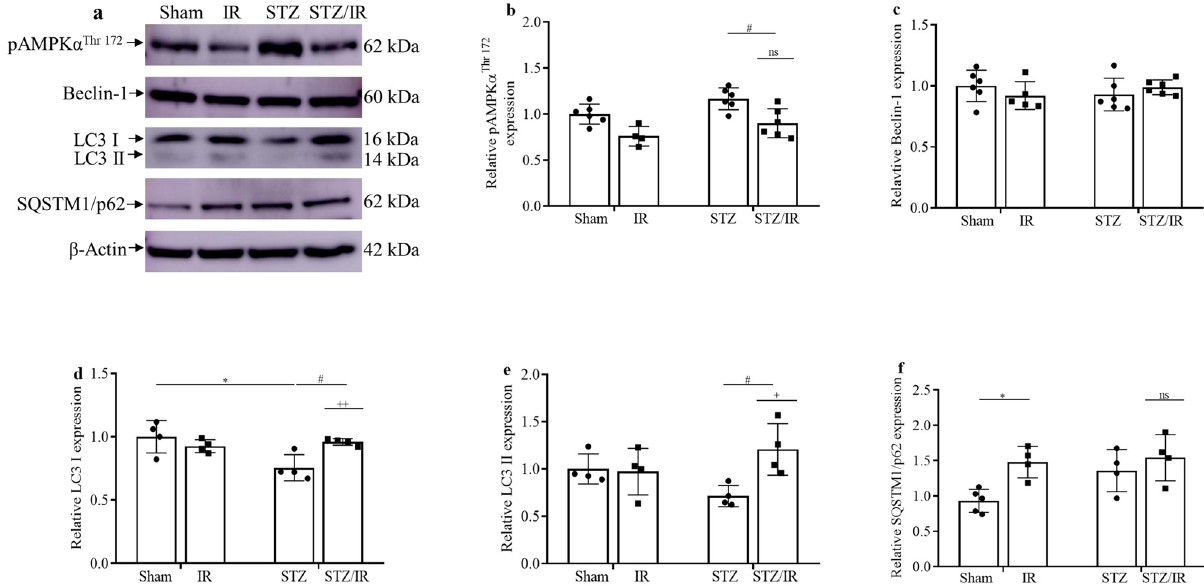
Figure 4. Effect of renal ischemia/reperfusion in vehicle- and STZ-treated mice on the protein expression ( a ) of phosphorylated AMPKα Thr 172 ( b ), beclin-1 ( c ), LC3 I ( d ), LC3 II ( e ), and SQSTM1/p62 ( f ). + p < 0.05, ++ p < 0.01 for the interaction between diabetes and renal IR (STZ/IR), as indicated by two-way ANOVA (Supplementary Table S2). The Bonferroni post hoc test was also performed: *p < 0.05 vs sham group; # p < 0.05 vs STZ group. The values are the mean ± SD (n = 4–6). The samples were obtained from the same experiment, and the blots were processed in parallel. Sham sham-operated, IR ischemia/reperfusion, STZ streptozotocin, STZ/IR streptozotocin/ischemia/reperfusion, ns nonsignificant. β-actin: positive